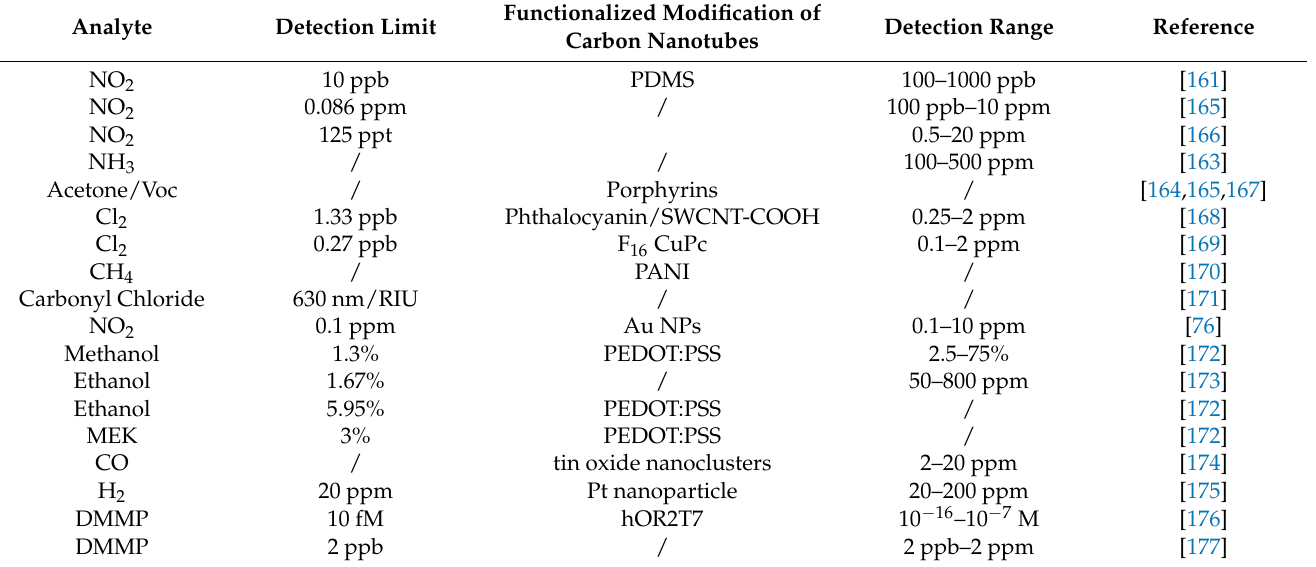
Table 3. Gas detection based on